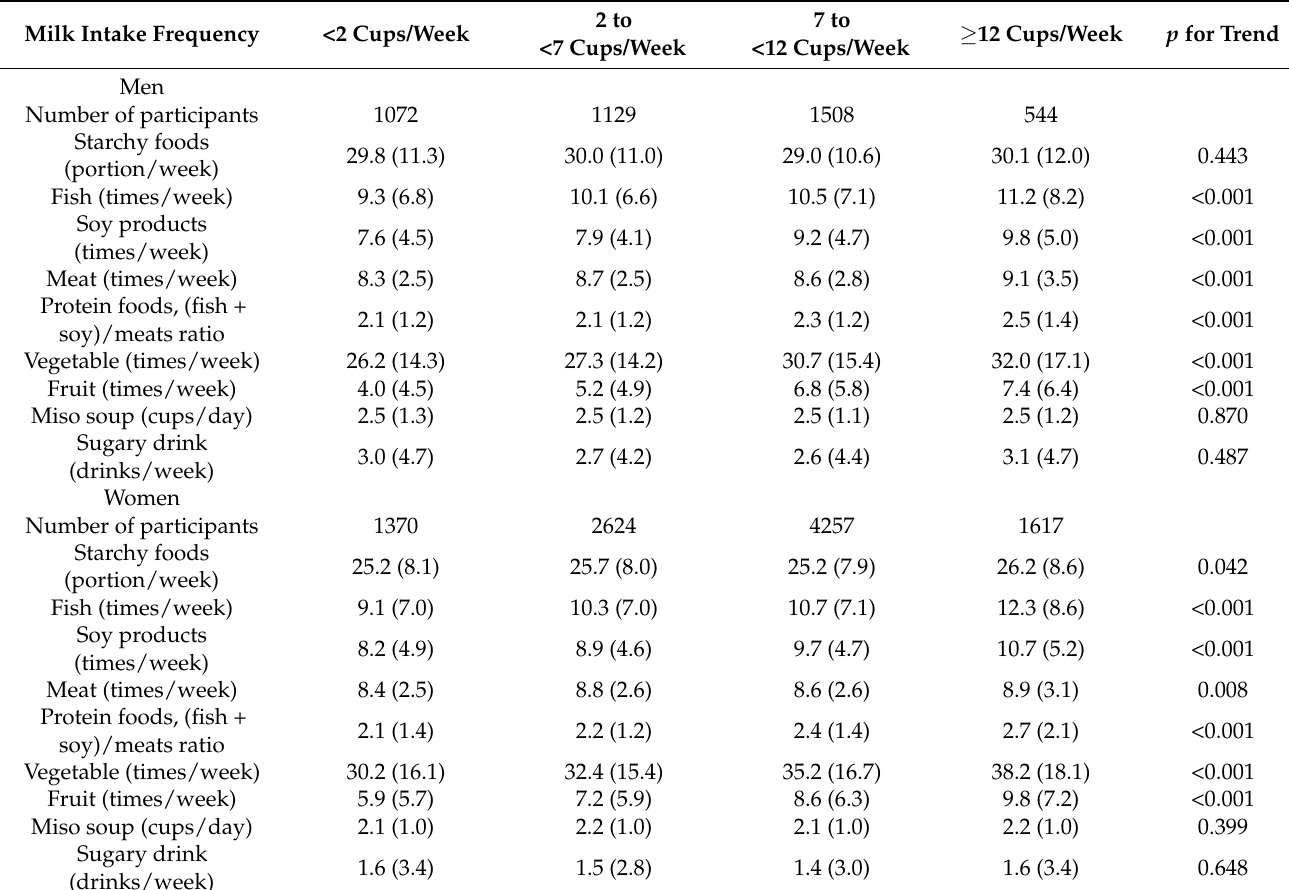
Table 2. Food intake frequency according to milk intake frequency categories by sex, 2002–2005, Iwate-KENCO study.